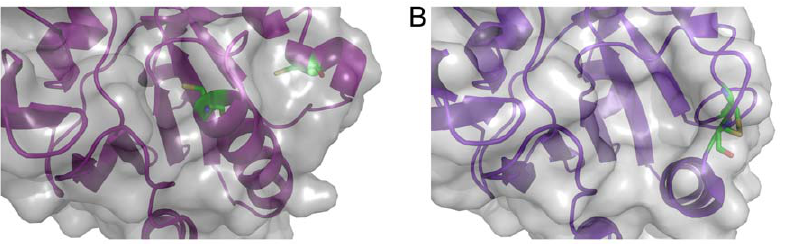
Figure 4. Comparison of the oxidised and reduced active site. (A) Close-up of the active cysteines in the reduced structure. C61 is shown to occlude the active site cleft. (B) Close-up of the reduced structure. The formation of the disulphide bond shifts the helix and opens a cleft, which allows substrate access.